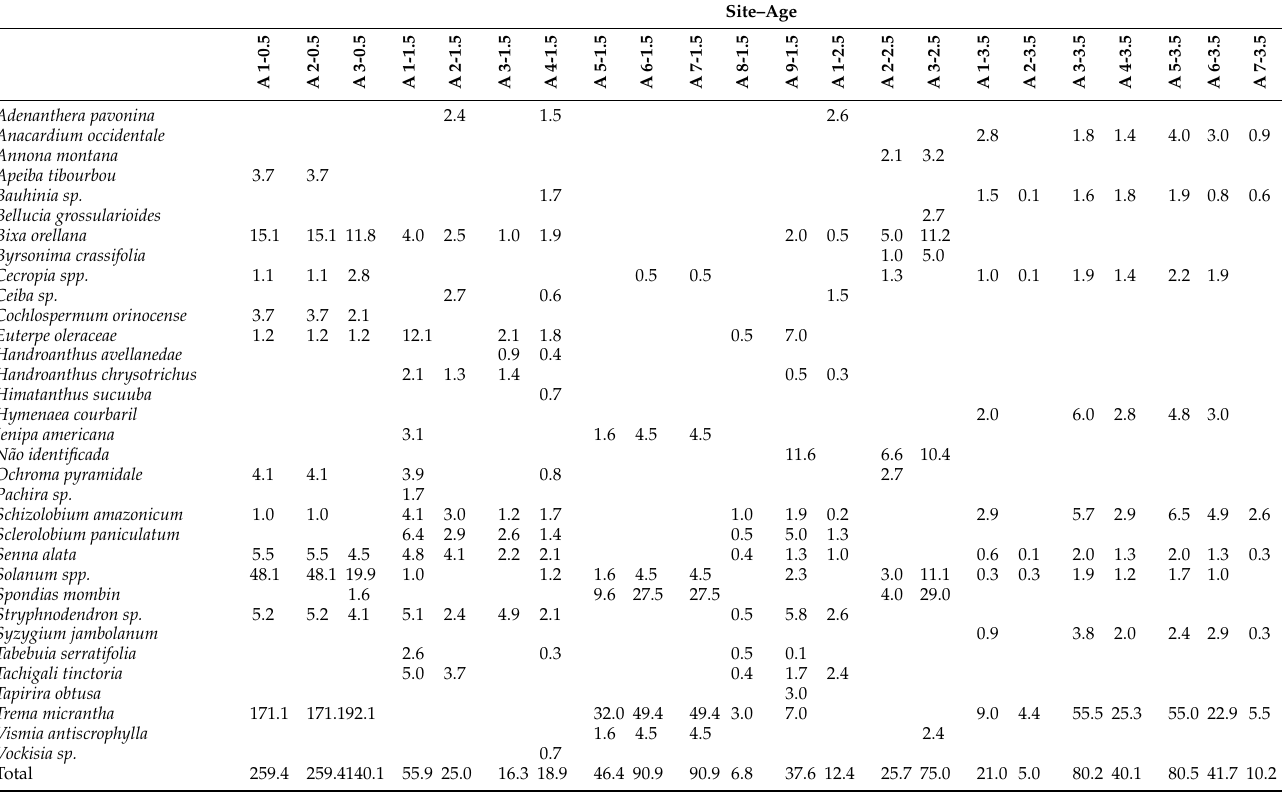
Table A1. List of the 33 species used in direct seeding with indications of the amount of seeds (measured in kilograms) sowed in each active restoration site after 2015. Each site is named with its area ID and age at the moment of sampling (2019). Sites are located south of the Jirau Hydroelectric Reservoir, along the upper Madeira River.